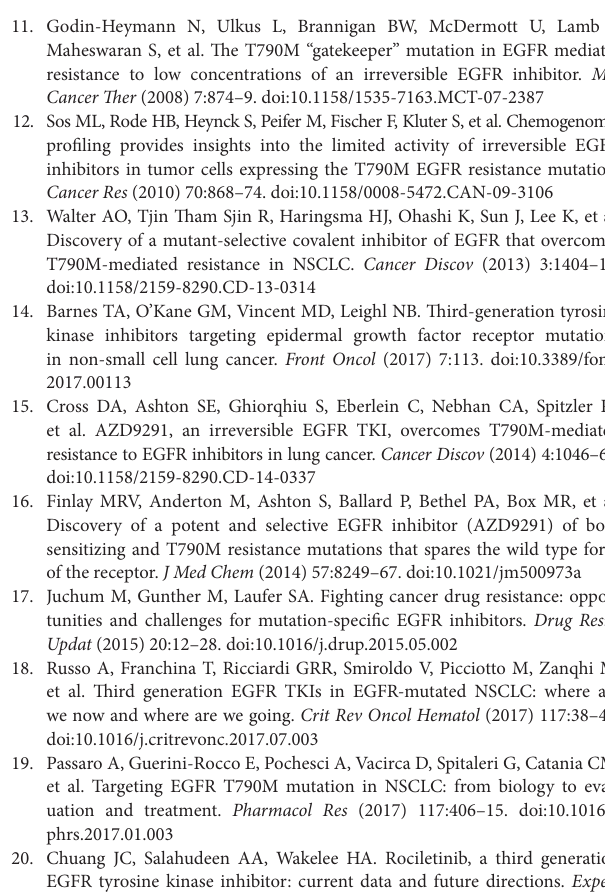
sensitizing mutation-bearing HCC827 cells and resistance-causing EGFR T790M mutation-bearing H1975 cells. The extent of inhibition of EGFR, Akt, and ERK phosphorylation is summarized after normalization with the respective total protein as bar graphs (lower panel). * p < 0.05, Student’s t -test, compared with the data in HCC827 cells. Cropped blots from different gels are grouped together for clear illustration. The full-length gels are shown in Figure S4 in Supplementary Material. FigUre s2 | Western blot analysis showing the inhibition of the EGFR–PI3K–Akt pathway by one of the three positive drug candidates ( cis -flupenthixol) in both EGFR sensitizing mutation-bearing HCC827 cells and resistance-causing EGFR T790M mutation-bearing H1975 cells. The extent of inhibition of EGFR, Akt, and ERK phosphorylation is summarized after normalization with the respective total protein as bar graphs (lower panel). * p < 0.05, Student’s t -test, compared with the data in HCC827 cells. Cropped blots from different gels are grouped together for clear illustration. The full-length gels are shown in Figure S5 in Supplementary Material. FigUre s3 | Full-length gels for the Western blot data shown in Figure 2 (indacaterol). FigUre s4 | Full-length gels for the Western blot data shown in Figure S1 in Supplementary Material (canagliflozin). FigUre s5 | Full-length gels for the Western blot data shown in Figure S2 in Supplementary Material ( cis -flupenthixol). FigUre s6 | Full-length gels for the Western blot data shown in Figure 5 (combination of gefitinib and